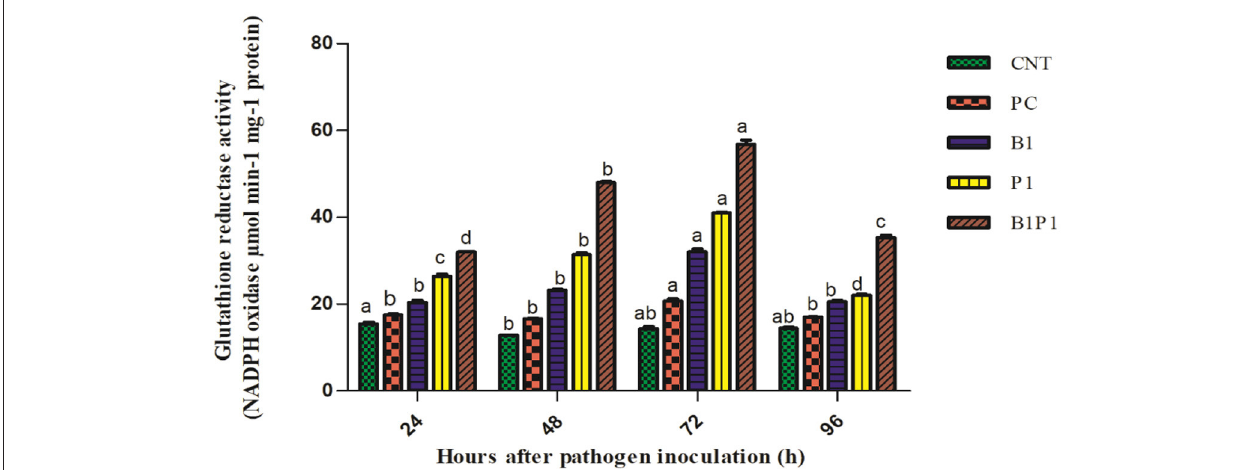
FIGURE 11 | The GR activity of the tomato leaves treated with different treatments of 24–96h of pathogen inoculation. Data are shown as a mean ± SE ( n = 3). Tukey’s B post-hoc test at 5% confidence level ( p < 0.05) was used to test the significance of the data. These alphabets denoted the different significant level.